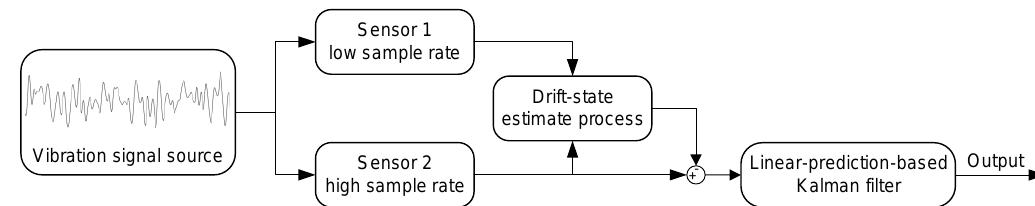
Figure 1. Block diagram of the hardware structure and the data-fusion algorithm.